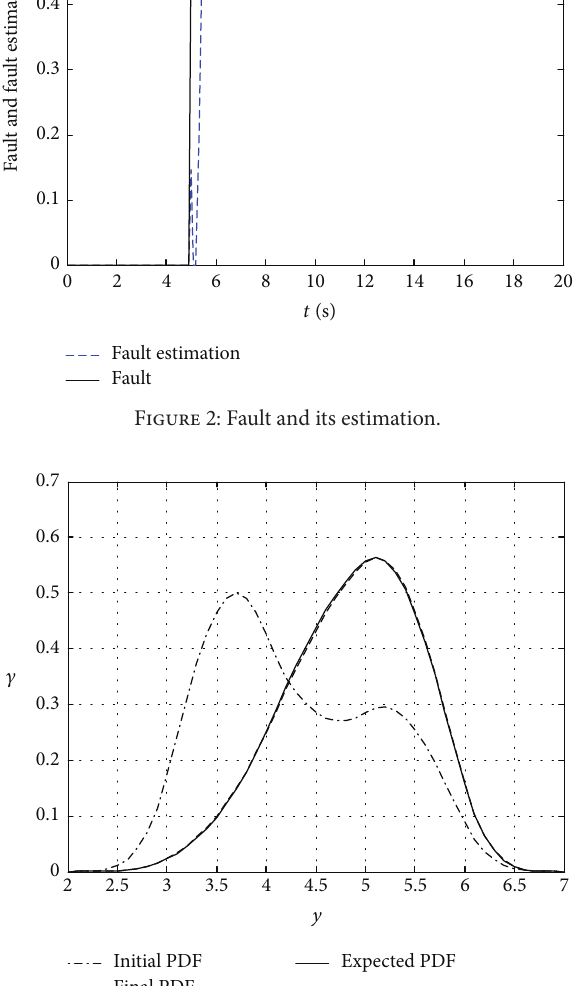
Figure 3: The output PDF with fault tolerant control when fault occurs.